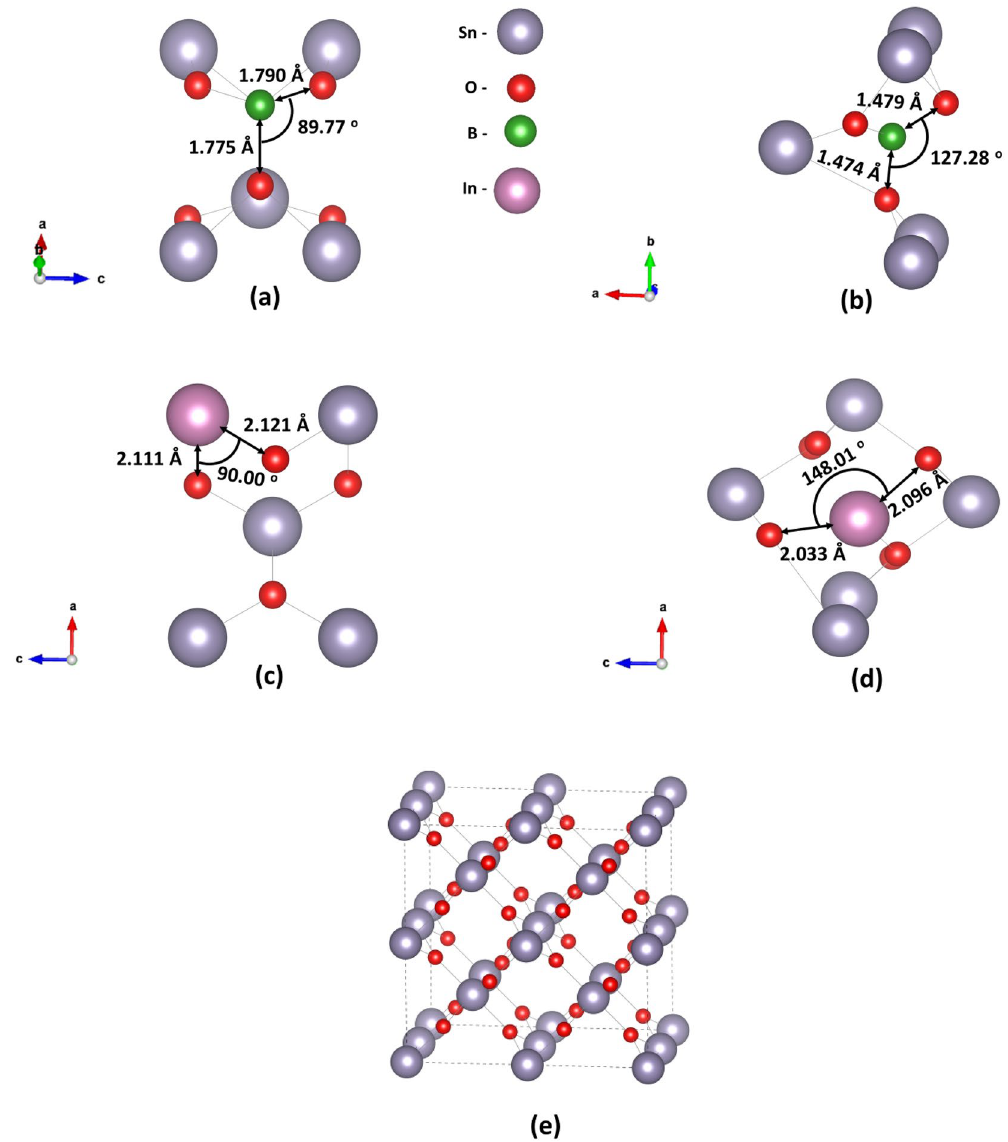
Figure 1. The structures of ( a ) boron substitutional doped SnO 2 (B Sn :SnO 2 ), ( b ) boron interstitial doped SnO 2 (B